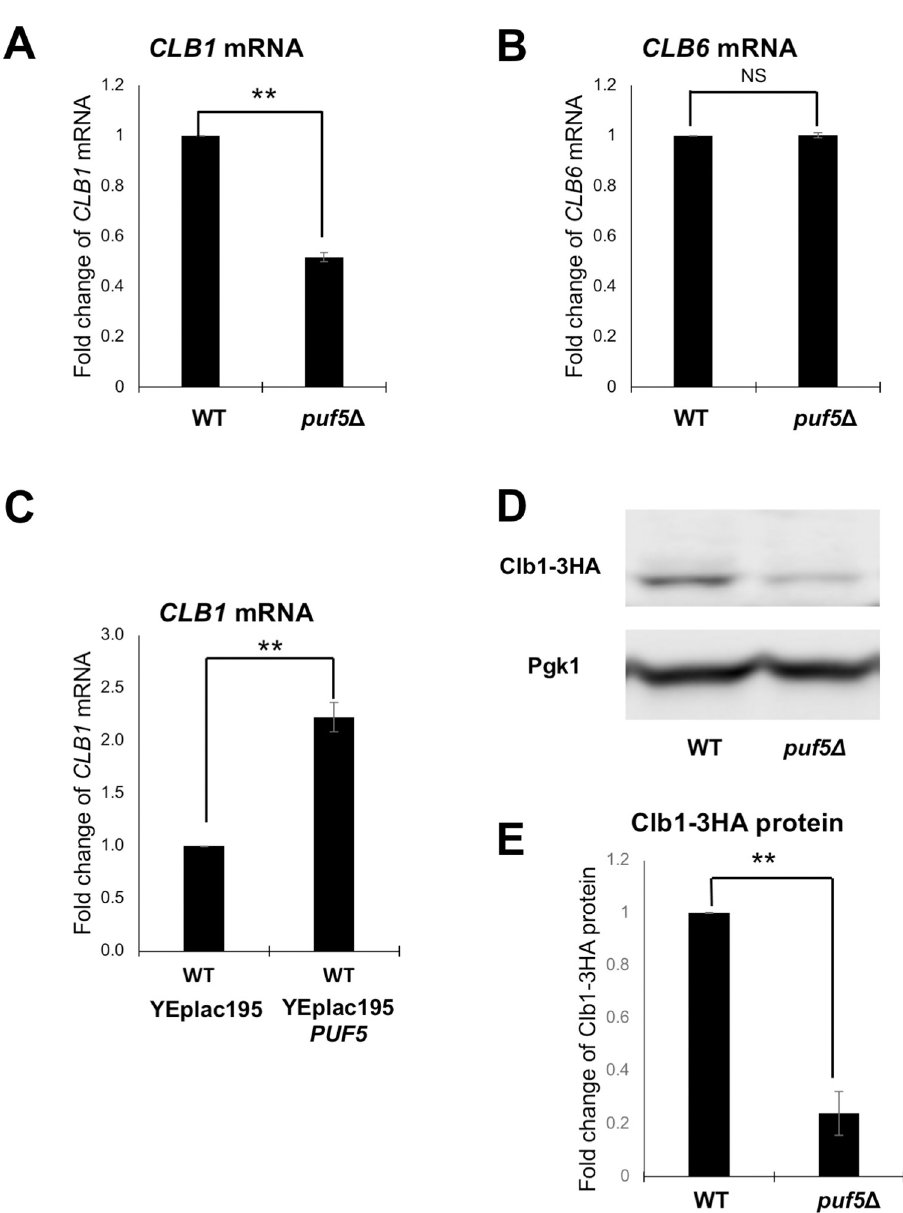
Fig 2. Puf5 positively regulates CLB1 expression. (A, B) The mRNA levels of CLB1 (A) and CLB6 (B) in wild-type and the puf5 Δ mutant. The cells were cultured in a YPD medium containing 10% sorbitol at 25˚C until the log phase. The CLB mRNA levels were quantified by qRT-PCR analysis, and the relative mRNA levels were calculated using the SCR1 reference gene. The data shows the mean ± SE (n = 3) of the fold change of CLB1 mRNA (A) and CLB6 mRNA (B) relative to the mRNA level in wild-type. � P < 0.05, �� P < 0.01 as determined by Tukey’s test. (C) The mRNA levels of CLB1 in the wild-type cell overexpressing PUF5 . The wild-type strains harboring plasmids YEplac195 or YEplac195- PUF5 were cultured in an SC-Ura medium at 28˚C until the exponential phase. The CLB1 mRNA levels were quantified by qRT-PCR analysis, and the relative mRNA levels were calculated using the SCR1 reference gene. The data shows the mean ± SE (n = 3) of the fold change of CLB1 mRNA relative to the mRNA level in wild-type harboring the YEplac195 plasmid. � P < 0.05, �� P < 0.01 as determined by Tukey’s test. (D, E) The Clb1 protein levels in wild-type and the puf5 Δ mutant, and the quantitative analysis data of Clb1-HA protein level. The strains harboring the YCplac33- CLB1-HA-CLB1 3´ UTR plasmid were cultured in an SC-Ura medium at 28˚C. The extracts were immunoblotted with anti-HA antibody or anti-Pgk1 antibody. Clb1-HA protein level was quantified and normalized with the Pgk1 protein level. The data shows the mean ± SE (n = 3) of the fold change of Clb1-HA protein relative to the protein level in wild-type (E). � P < 0.05, �� P < 0.01 as determined by Tukey’s